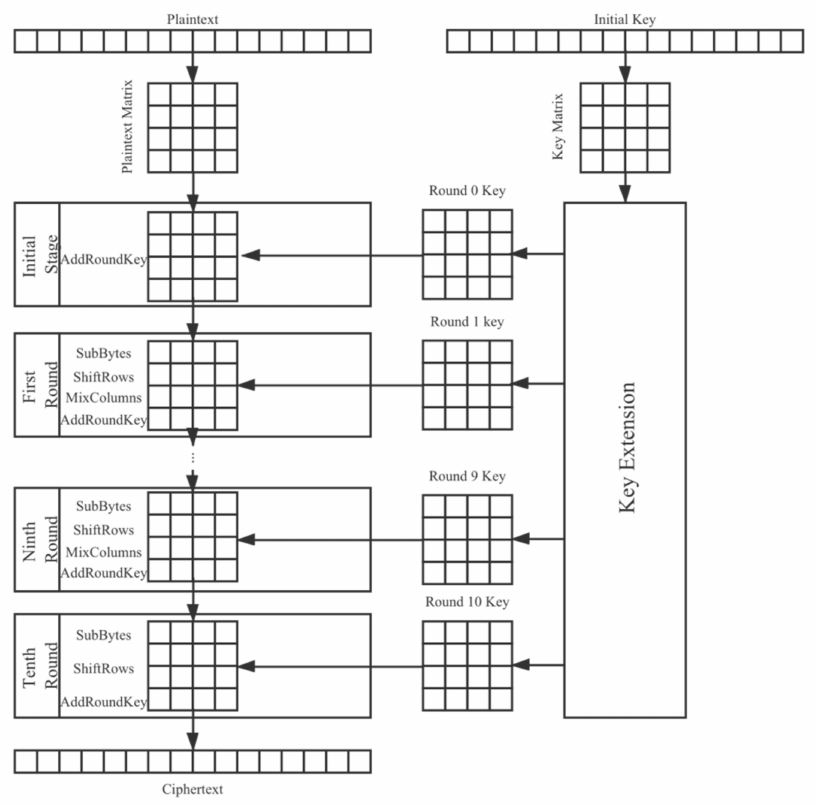
Figure 2. Encryption process of the AES algorithm.